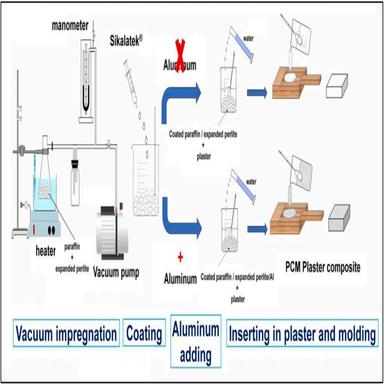
Experimental set-up of PCM Plaster preparation.